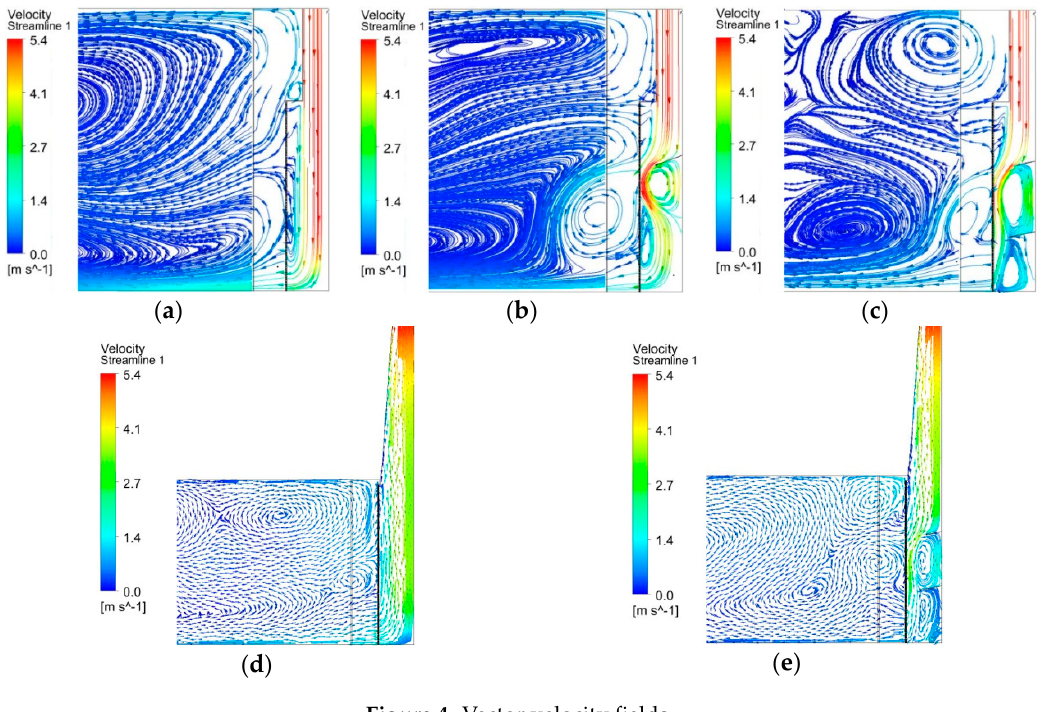
Figure 4. Vector velocity fields.